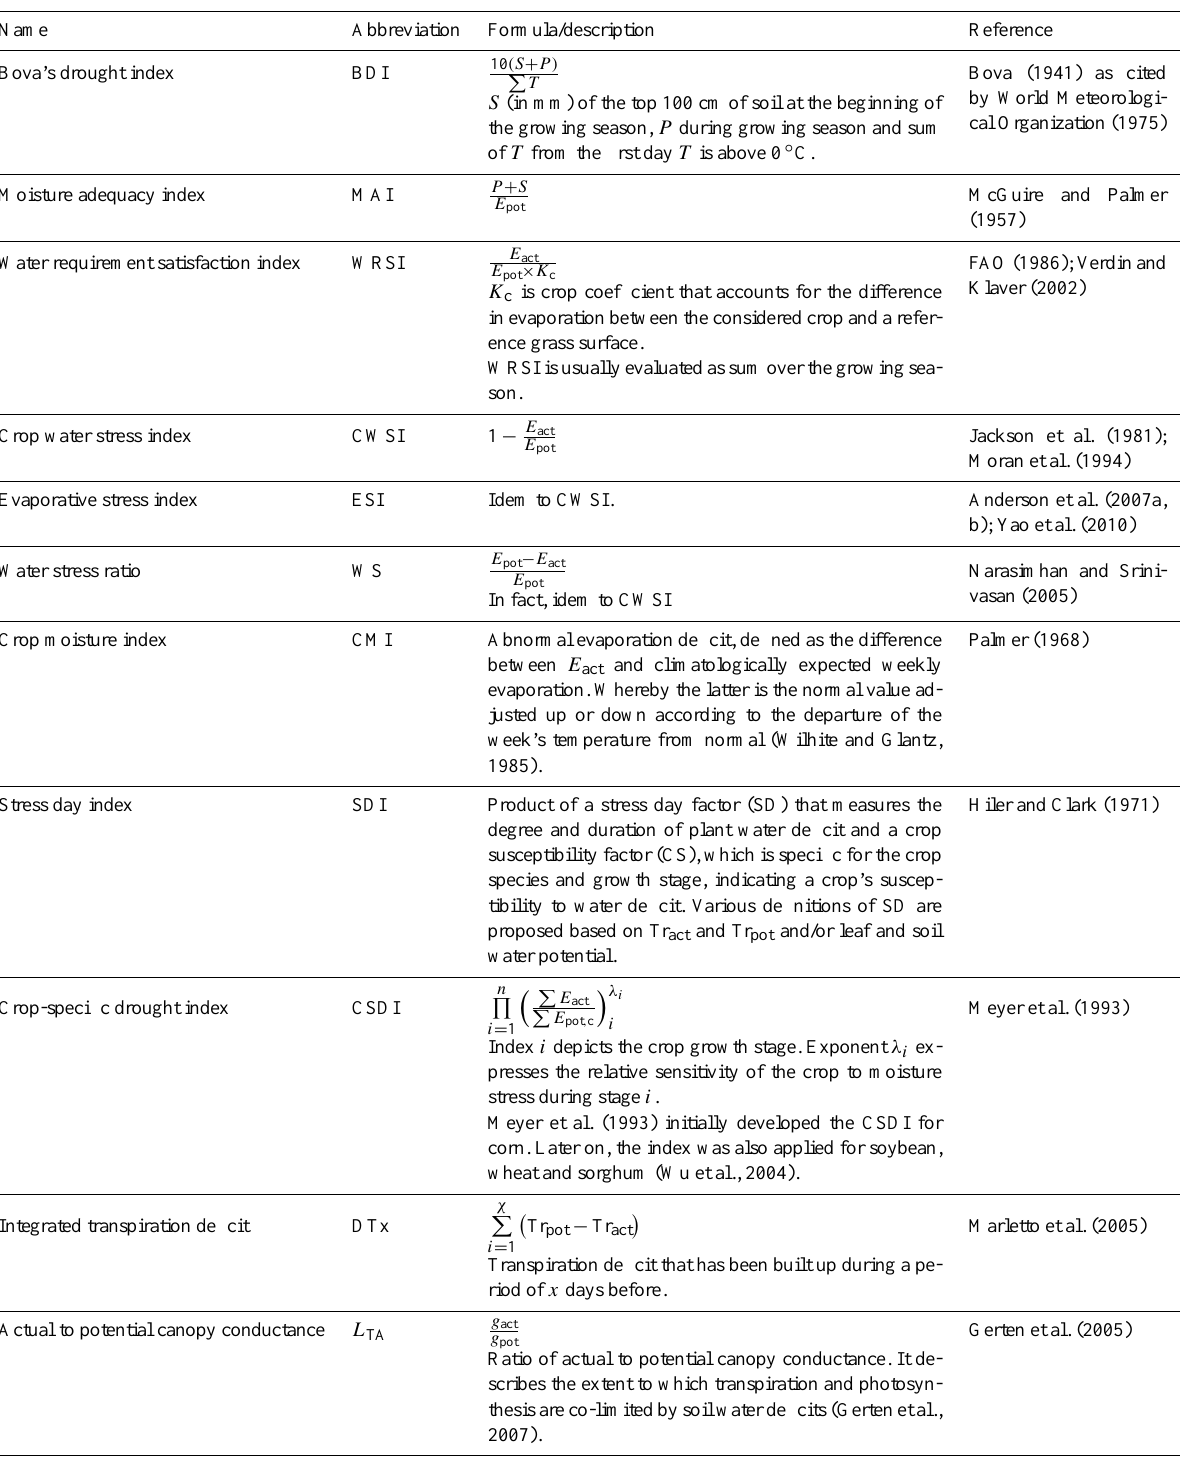
Table A2. Agricultural drought